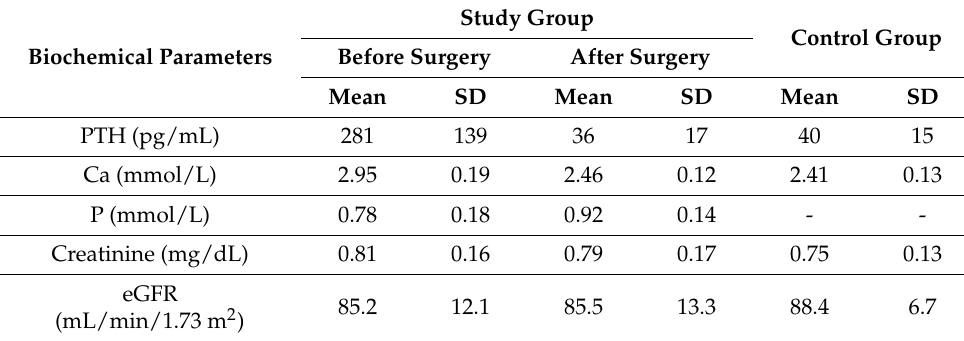
Table 1. Biochemical parameters of study group and control group.